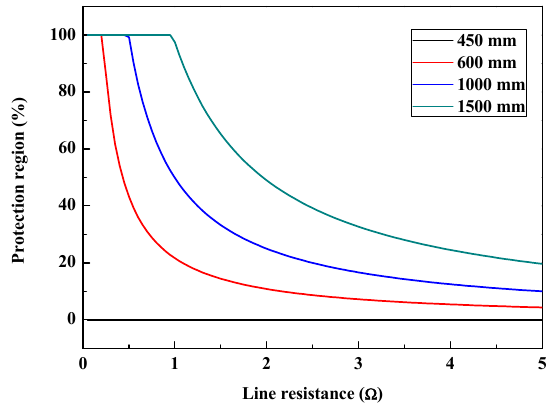
Figure 15. Influence of line resistance on protection region of arcing horns. Table 4. Influence of line resistance on protection region of arcing horns.